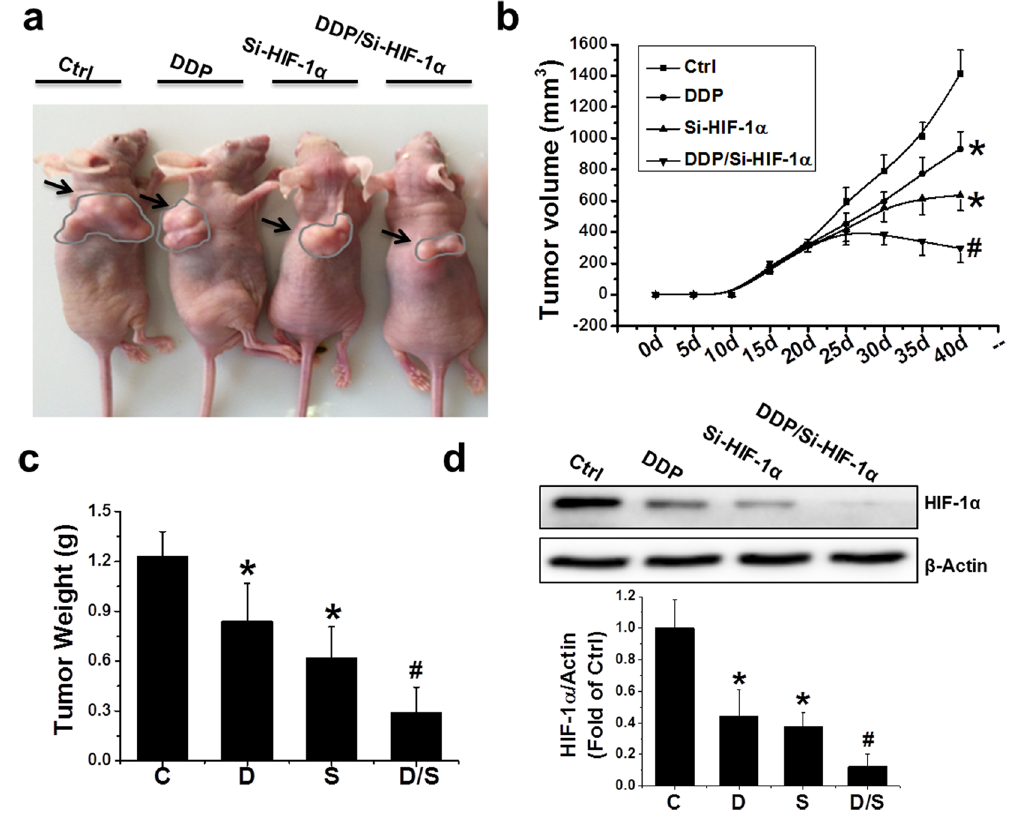
Figure 3. Inhibition of tumor growth in vivo by various treatments. ( a ) Macroscopic view of mouse tumors at the end of the study. ( b ) Tumor growth curves from day 0 to 40, with tumor sizes measured every 5 days, in various treatment groups as indicated. ( c ) Wet weight of tumors measured at the end of the study. ( d ) Protein expression of HIF-1 α examined by western blot in PC-3 xenografts exposed to various treatments. Data were presented as mean ± SD (n = 6). * p < 0.05 versus control group; # p < 0.05 versus si-HIF-1 α or DDP group. The original blots are presented in Supplementary Figure